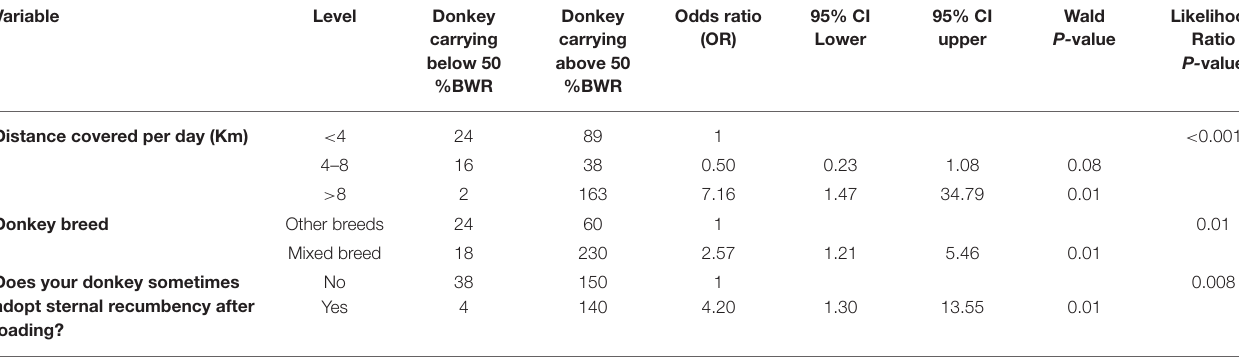
TABLE 3 | Multivariable regression model for 50% body weight ratio (%BWR) of load carrying donkeys. Variable Level Donkey